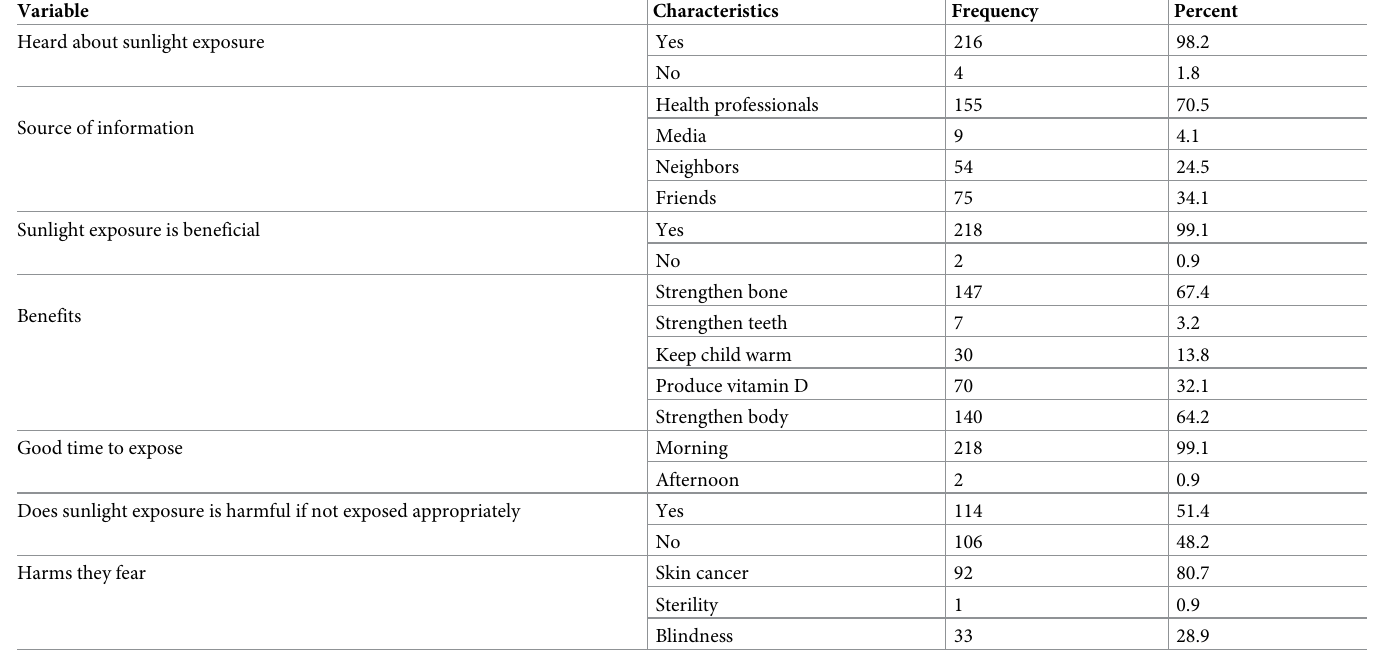
Table 3. Knowledge of mothers about infants’ sunlight exposure among mothers attending EPI unit at WUSH, 2021.